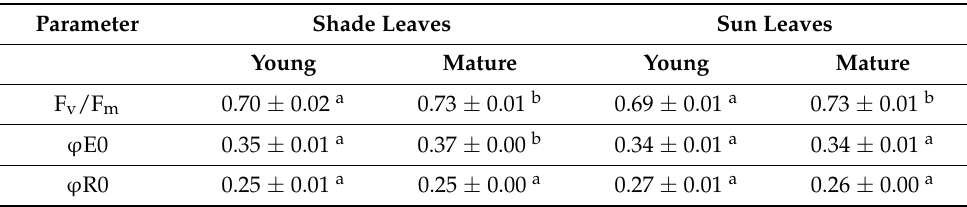
Figure 7. Chlorophyll a fluorescence fast induction (OJIP) averaged curves. The curves of 10 leaves for each variant were averaged and normalized to maximum. Table 4. Key parameters of fluorescence induction in young and mature leaves of Hydrocharis morsus-ranae in the different lighting.